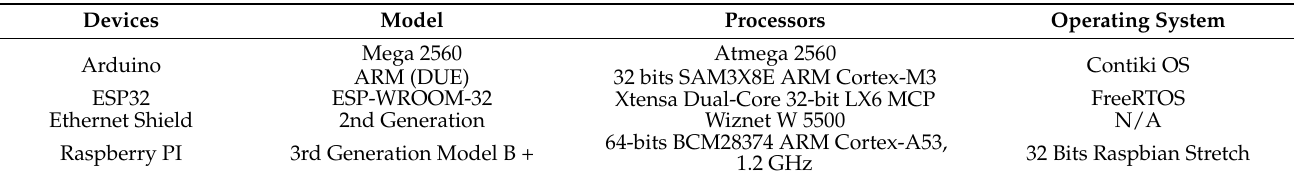
Table 1. Experimental setup hardware used for the home area